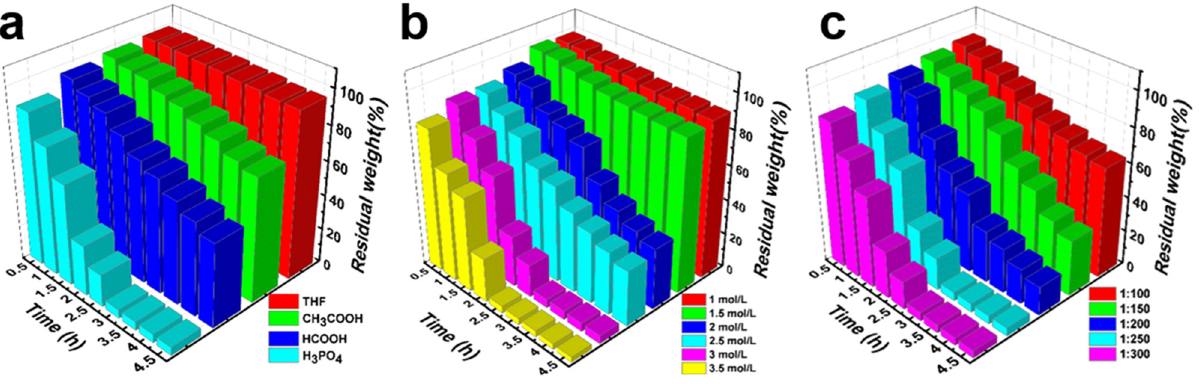
Figure 7: The e ff ect of di ff erent conditions on the degree of mercaptan degradation: ( a ) the type of acids, ( b ) concentration of acids, and ( c ) the mass ratio of CNT fi lms to the acid solution.